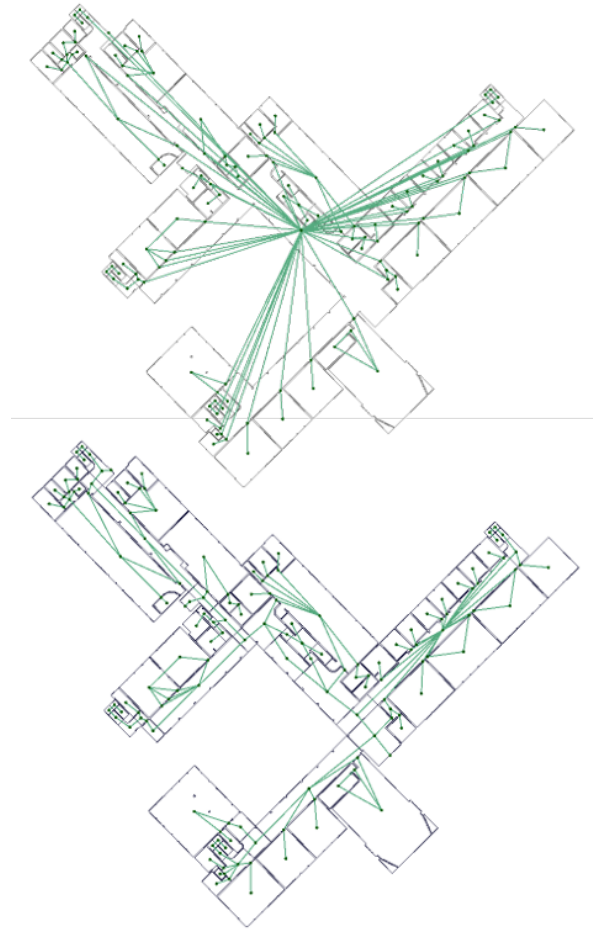
Figure 12. Spaces subdivision. Upper figure the transit space is considered without further subdivisions. Lower figure shows the transit space subdivided in several parts according to its structure As for the IndoorGML model, it was necessary to subdivide the spaces. For example, if we considered only the tangible limits of the corridor on the first floor of the faculty, it would only exist one object in the TransitionSpace class, and its respective dual or node in the State class. This node is in the center of geometry, where all the connectivity relations defined by the transition class converge. As seen in figure 12, this scenario is not suitable for a navigation purpose because the lines crossing the non-navigable boundaries. Therefore, the subdivision was necessary to get as a result a much more organized IndoorGML model, as seen in the lower part of the figure